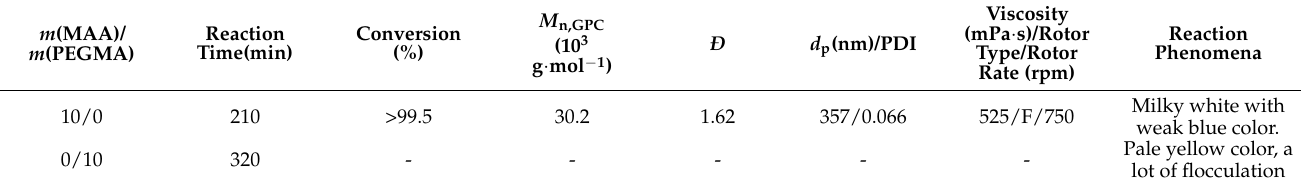
Table 5. Results of emulsion with MMA units in polymer chain.